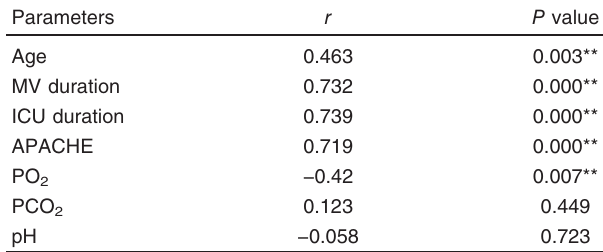
APACHE, acute physiology and chronic health evaluation; MV, mechanical ventilation. **Highly